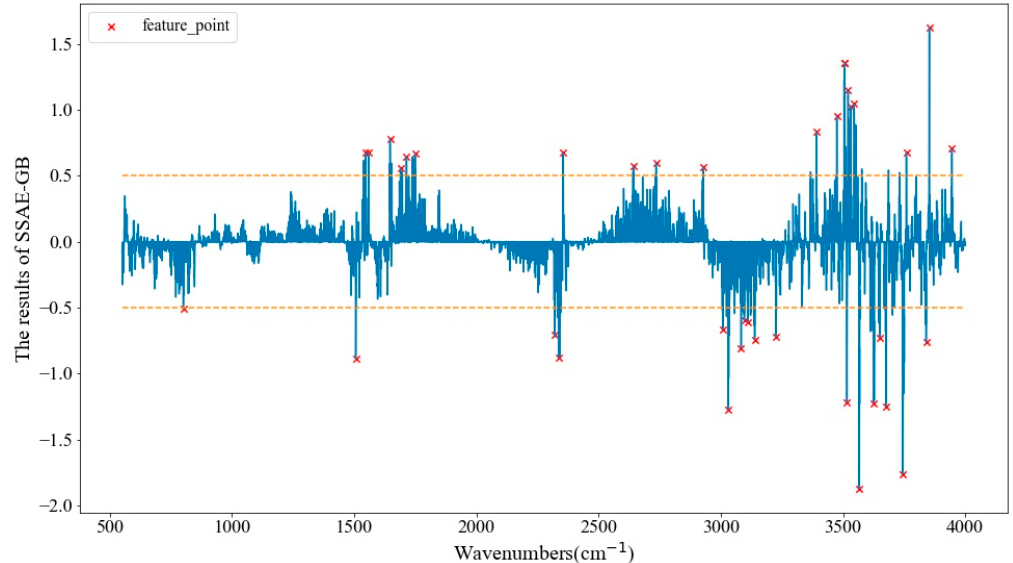
Figure 3. The partial guided result of stacked sparse auto-encoder guided backward (SSAE-GB) with selected wavenumbers.